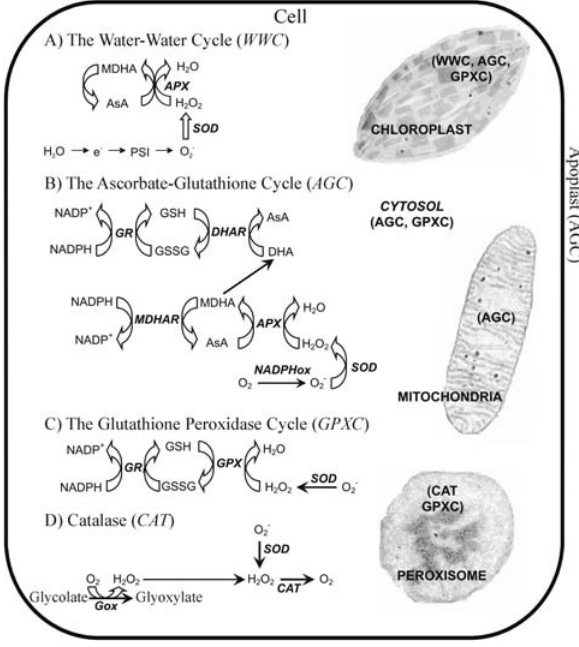
Figure 1 - Localization of reactive oxygen species (ROS) scavenging pathways in plant cells. (A) The water-water cycle (WWC); (B) The ascorbate-glutathione cycle (AGC); (C) The glutathione peroxidase cycle (GPXC); (D) Catalase (CAT). APX, ascorbate peroxidase; AsA, ascor- bate; CAT, catalase; DHA, dehydroascorbate; DHAR, dehydroascorbate reductase; Gox, glycolate oxidase; GPX, glutathione peroxidase; GR, glutathione reductase; GSH, glutathione; GSSG, oxidized glutathione; MDHA, monodehydroascorbate; MDHAR, monodehydroascorbate re- ductase; NADPHox, NADPH oxidase; PSI, photosystem I and SOD, superoxide